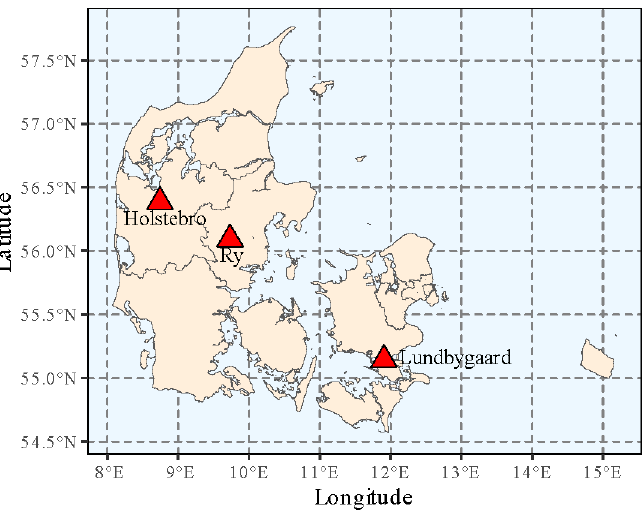
Figure 2. Location of the three SE clonal trials in Denmark.